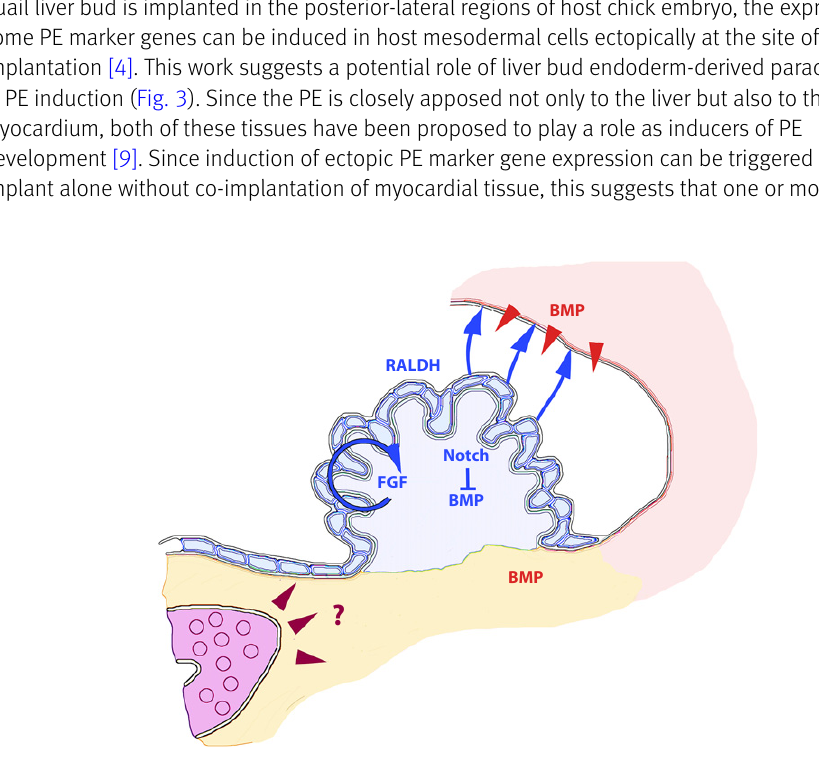
Figure.3 SignalingmoleculesinvolvedinPEspecificationandsecondarytissuebridgeformation. Theliver(pink structure) secretes presently unknown PE inducing molecules. BMP is expressed in the sinus horn